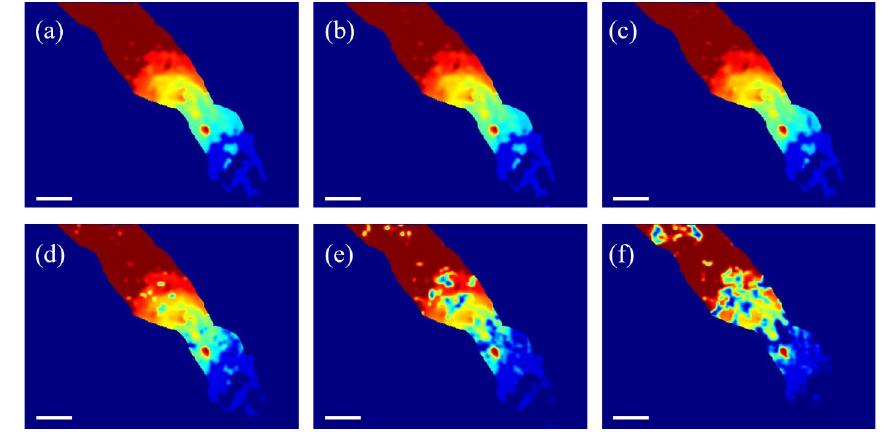
Fig. 14 Effect of different custom threshold T values on the deep fusion of samples. (a) T = 3, (b) T = 7, (c) T = 13, (d) T = 16, (e) T = 20 and (f) T = 25. The scale bars in these pictures are 10 μm